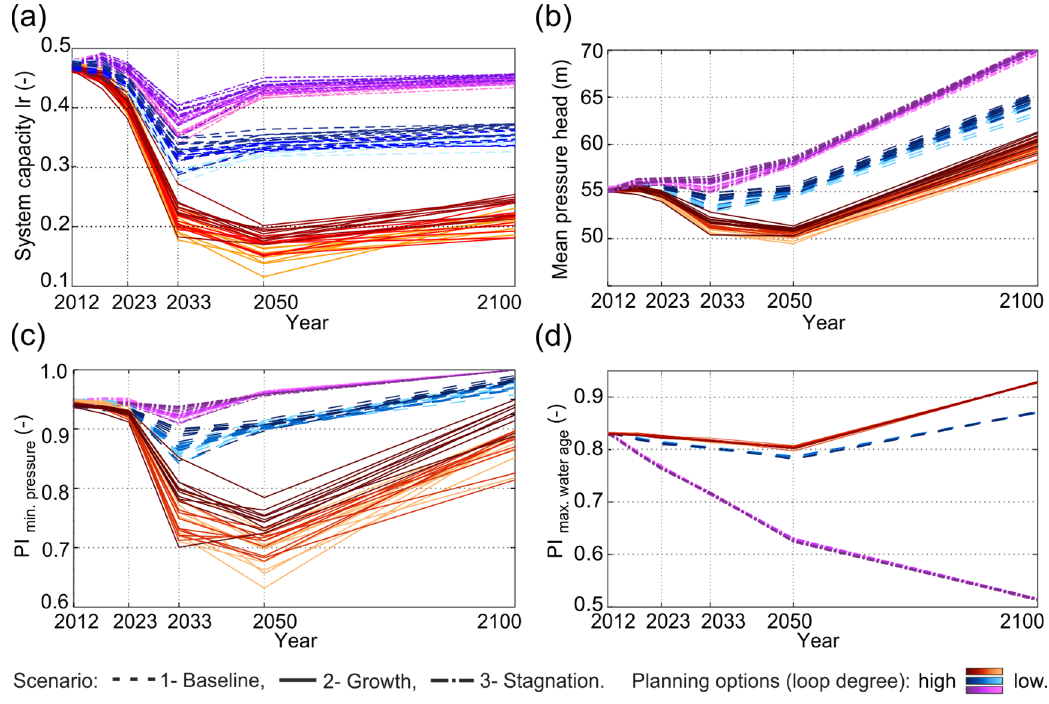
Figure 10. Performance developments for three demand scenarios and WDS structure variations; ( a ) System capacity, ( b ) Mean pressure head, ( c ) Minimum pressure performance and ( d ) Maximum water age performance.